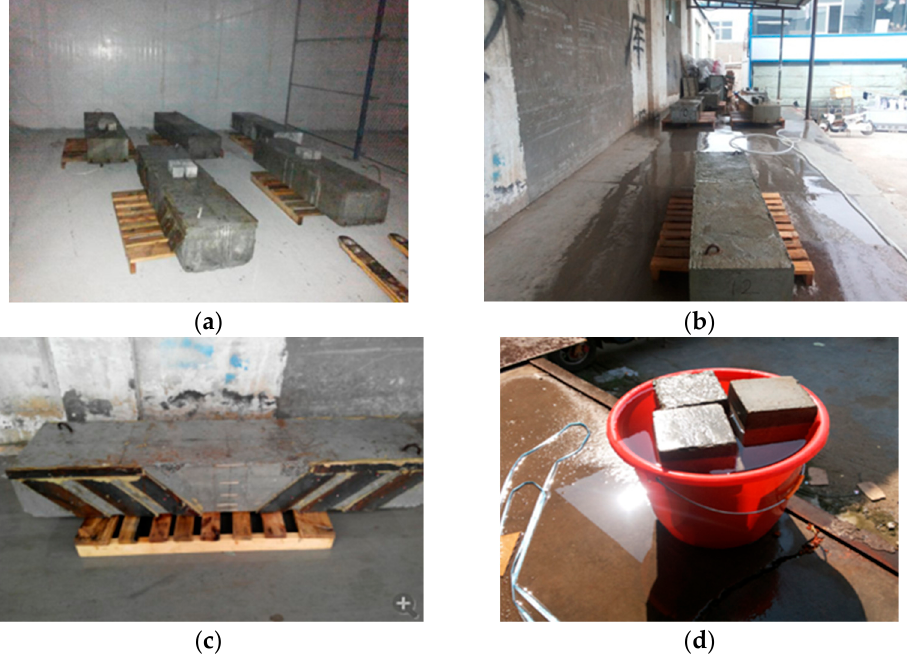
Figure 8. Freeze–thaw test process for the reinforced test plate and corresponding test blocks: ( a ) freezing of the reinforced test plate; ( b ) water melting of the test plate; ( c ) melted test plate; ( d ) simultaneous immersion melting of the test blocks.